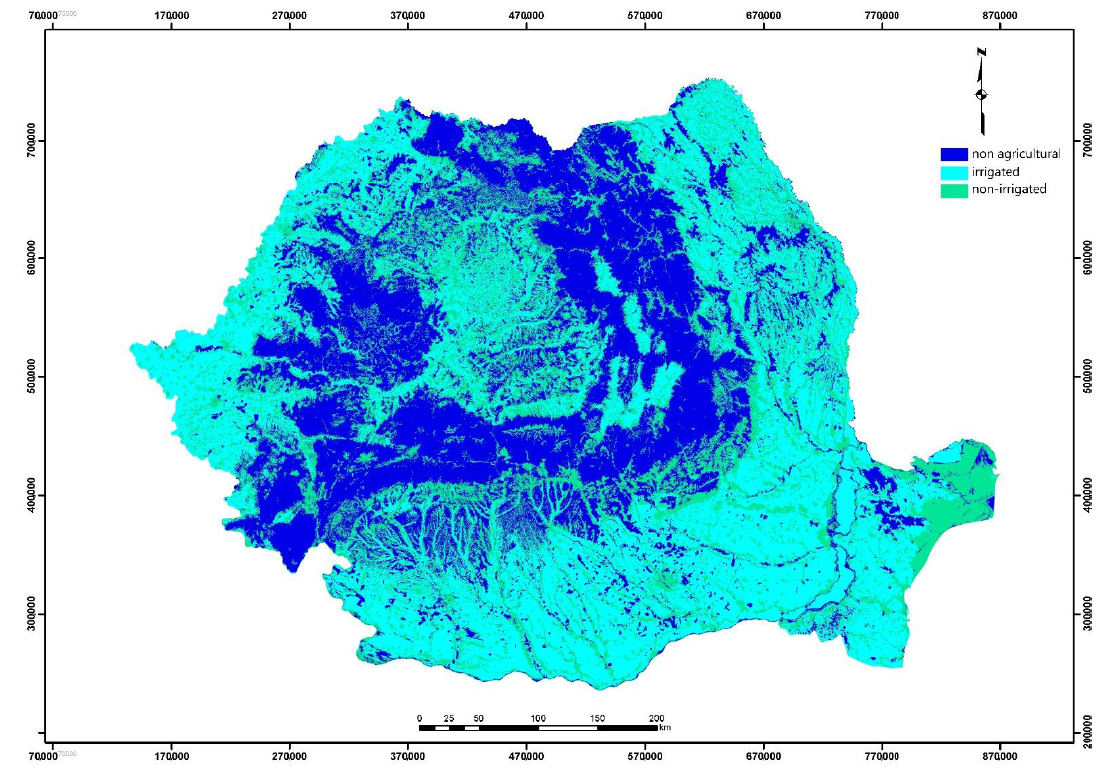
Figure 5. Initial processing of input data: agricultural activities. Int. J. Environ. Res. Public Health 2021 , 18 , 5915